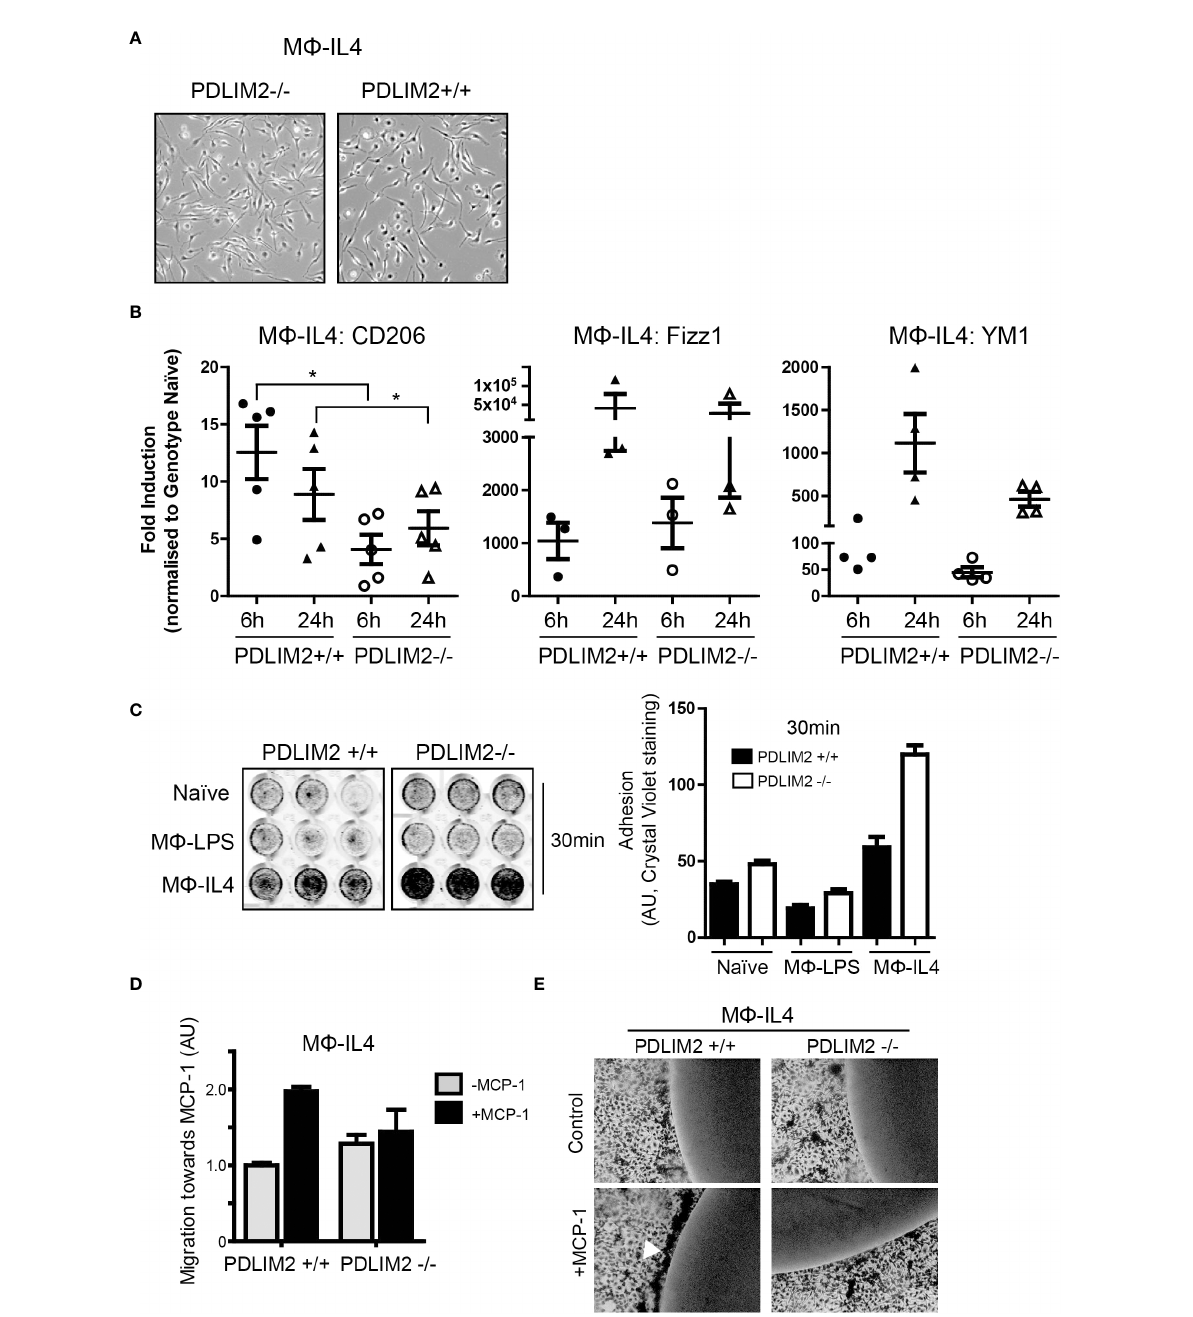
FIGURE 4 PDLIM2 is essential for complete adoption of macrophage M2-phenotype and activity. (A) : Representative micrographs of PDLIM2+/+ and -/- BMDM stimulated with IL-4 for 24hr (M Ф -IL4). Original magni fi cation is 10X. (B) : Gene expression of M2 markers CD206, Fizz1 and YM1 measured by qPCR in IL-4 stimulated PDLIM2+/+ or -/- BMDM, for 6 or 24h (M Ф -IL4). Graphs show fold-induction of gene expression compared to genotype naive (PDLIM2+/+ or -/-), each data point represents an independent experiment, *P<0.05. (C) : Adhesion assays for PDLIM2+/+ or -/- BMDM, naïve or stimulated with IL-4 or LPS (M Ф -IL4, M Ф -LPS, 24h) at 30min. Representative data from one of 3 adhesion assays with similar results is shown. (D) : Cell migration towards MCP-1 was measured using transwell migration assays on M Ф -IL-4 PDLIM2+/+ or -/- BMDM. Data is normalised to cell migration in the absence of MCP-1 (grey bars), with fold difference in response to MCP-1 shown (black bars), AU; arbitrary units of crystal violet staining. One of 3 independent experiments with similar results is shown. (E) : Chemotaxis agarose spot assays were performed on IL-4-stimulated BMDM from PDLIM2+/+ and -/- mice (24h). The arrow indicates BMDM migrating towards the MCP- 1 gradient accumulate at the edge of the MCP-1 agarose spot. Original magni fi cation is 10X. Also see data supplementary to D and E in Supplementary Figure